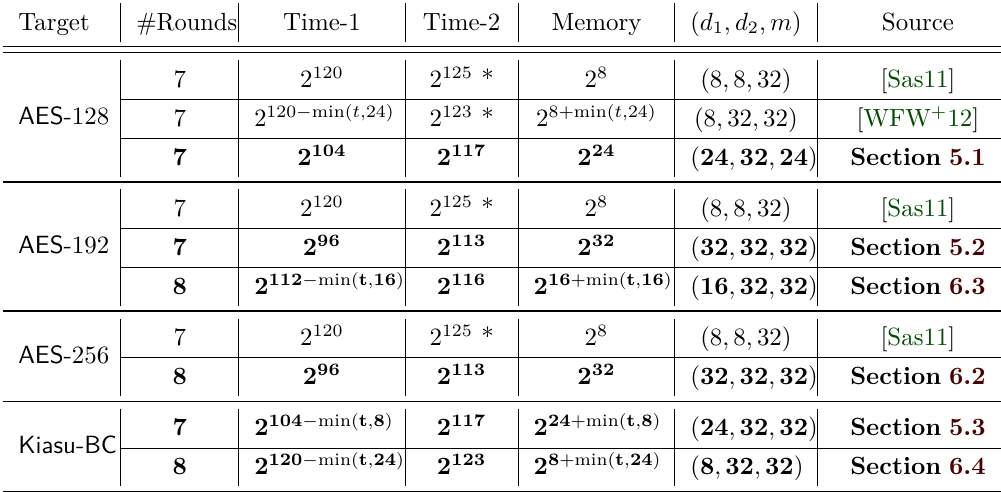
Table 1: Summary of our improved pseudo-preimage attacks against the round-reduced compression function of AES hashing modes, compared with previous